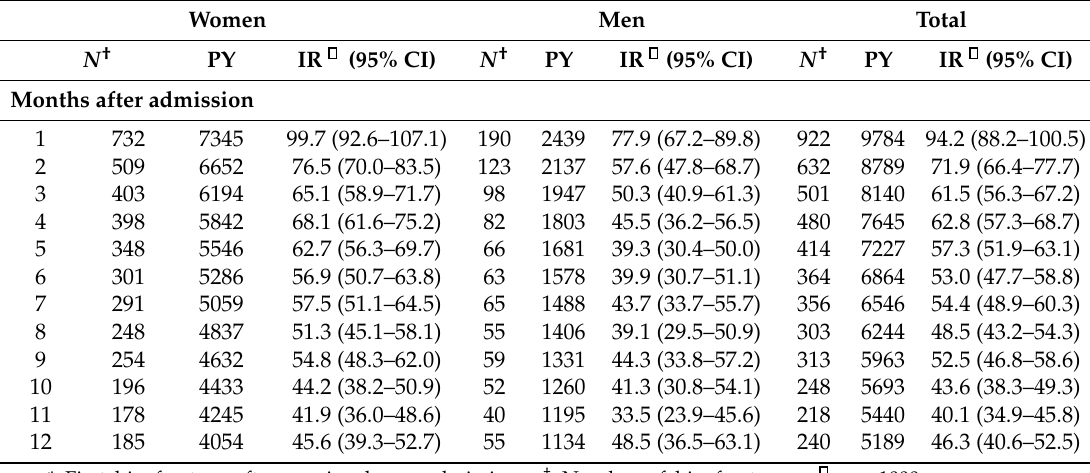
Table A1. Time after admission stratified hip fracture rates * in newly admitted nursing homes residents between 2010 and 2014, by